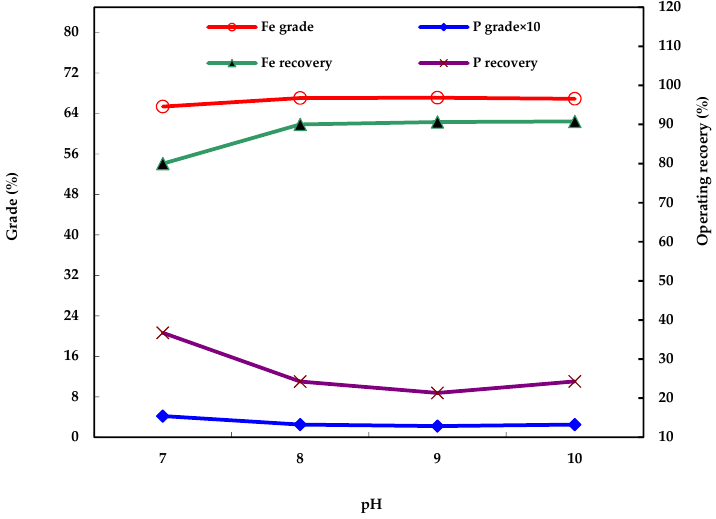
Figure 7. Effects of pulp pH value on iron and phosphorus grades and recoveries in reverse flotation.